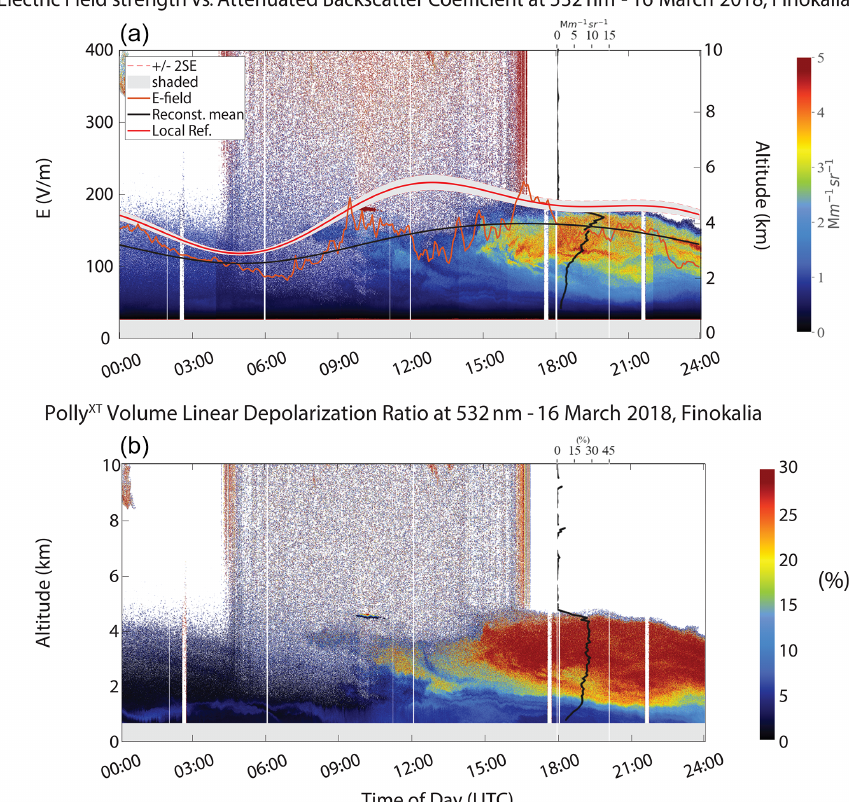
Figure 8. (a) Time series of the vertical electric field strength (orange), the extracted localized reference (ref.) electric field (red) and the reconstructed (reconstr.) mean electric field variation (black) from the field mill dataset, for the recorded 16 March 2018 dust layer at Finokalia. The E-field data are plotted with the time–height evolution of the attenuated backscatter coefficient (Mm − 1 sr − 1 ) and the particle backscatter coefficient ( β ) profile (Mm − 1 sr − 1 , black vertical line) at 532nm from the Polly XT lidar, which was co-located with the field mill. Areas of increased particle concentration are denoted with red tones, while the β values are derived by averaging between 18:00 and 21:00UTC. (b) Volume linear depolarization ratio ( δ v , %) at 532nm for the same dust layer as obtained from the Polly XT lidar and the particle linear depolarization ratio ( δ p , %) profile (black vertical line), again averaged between 18:00 and 21:00UTC. Large δ v values are depicted with red